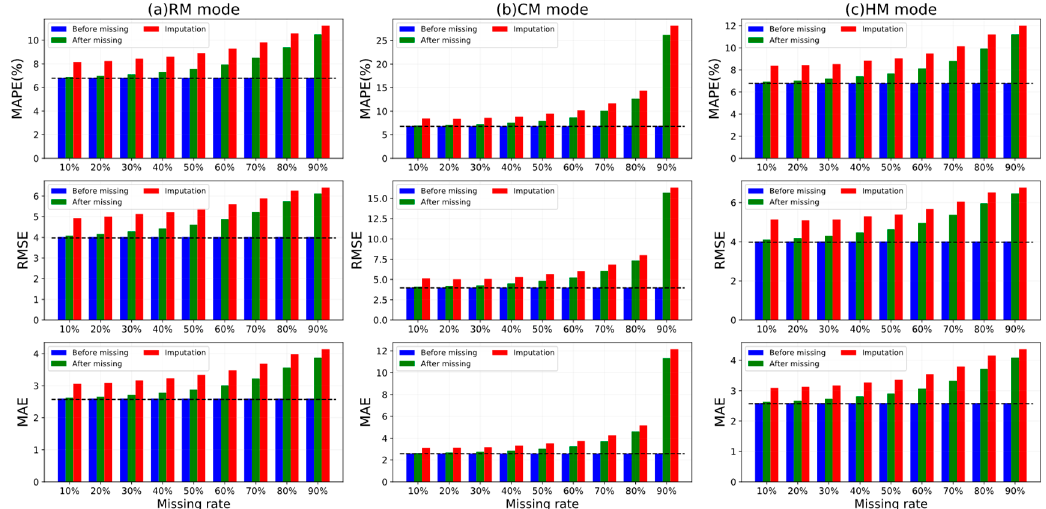
Figure 10. Imputation and prediction results of ST-CRMF model on Seattle-Loop dataset for RM, CM, and HM scenarios and 10–90% missing rates. Blue and green denote the predictive indicators of the non-missing and missing cases, respectively; red denotes the recovery metrics after missing.